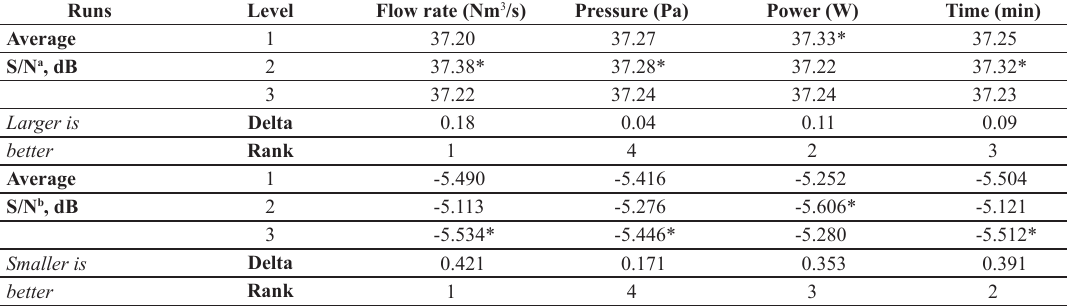
Table 3. Response table for mean of S/N ratio to optimize water vapour permeability ( S/N a ) and resistance ( S/N b ) of the fabric.